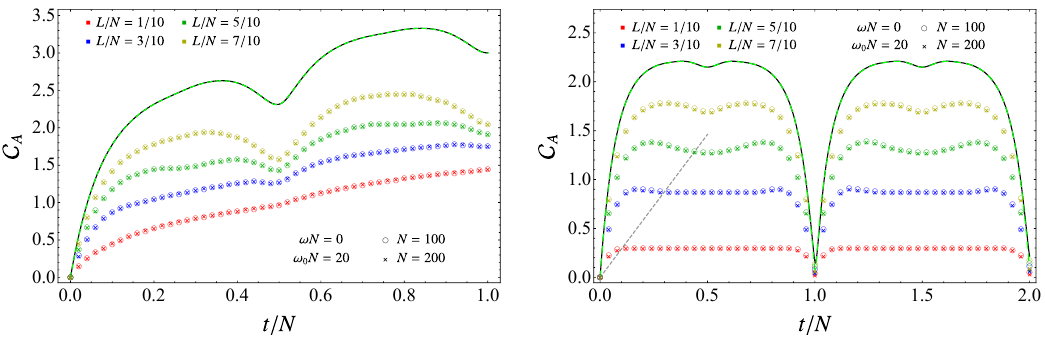
Figure 6 . Temporal evolution of C A in (4.6) after the global quench with gapless evolution Hamil- tonian and ω 0 N = 20 , for a block A made by L consecutive sites in harmonic chains with either PBC (left panels) or DBC (right panels) made by N sites (in the latter case A is adjacent to a boundary). When L = N , the complexity (3.7) is shown for N = 100 (solid black lines) and N = 200 (dashed green